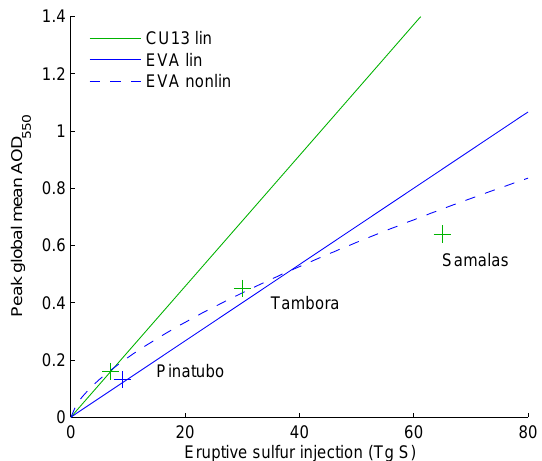
Figure 13. Relationships between eruptive stratospheric sulfur in- jections and peak global mean AOD 550 from the CU13 reconstruc- tion and EVA. Green crosses show the peak AOD values and injec- tion estimates values from the CU13 reconstruction for Pinatubo, Tambora, and Samalas. The green line shows the linear relation- ship which would be deduced from the Pinatubo data used in CU13, extrapolated to all injection magnitudes. The blue cross shows the peak AOD and sulfur injection estimates from satellite sensors used in EVA to construct a linear relationship, shown by the blue solid line. The blue dashed line shows the two-thirds power-law relation- ship used in EVA for eruptions larger in magnitude than